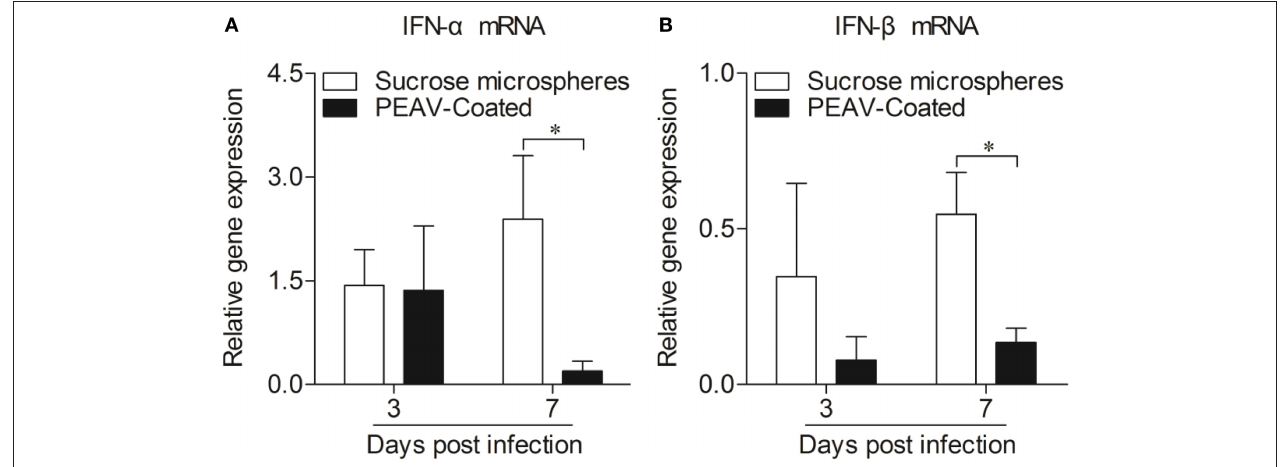
FIGURE 5 | Expressions of mRNA of type I interferon in Peyer’s patches from weaned piglets after infection with PEAV-Coated at 3 d.p.i. and 7 d.p.i. The mRNA expressions of IFN- α (A) and IFN- β (B) in Peyer’s patches from weaned piglets after infection with PEAV-Coated were examined with real-time PCR using specific primers at 3 d.p.i. and 7 d.p.i. The mRNA expression levels of these cytokines were calculated relative to the expression level of GAPDH . Data are represented as mean ± SD, n = 6. * p <